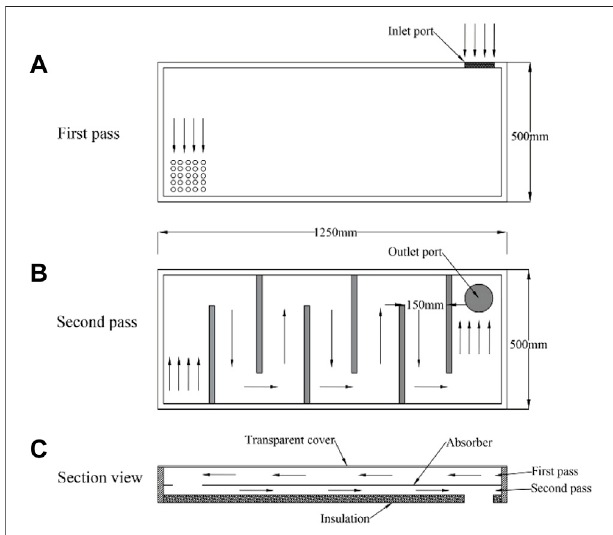
FIGURE1| Thedirectionof fl owofairinthetwo-passsolarcollector. (A) fi rst pass, (B) second pass, (C) section view